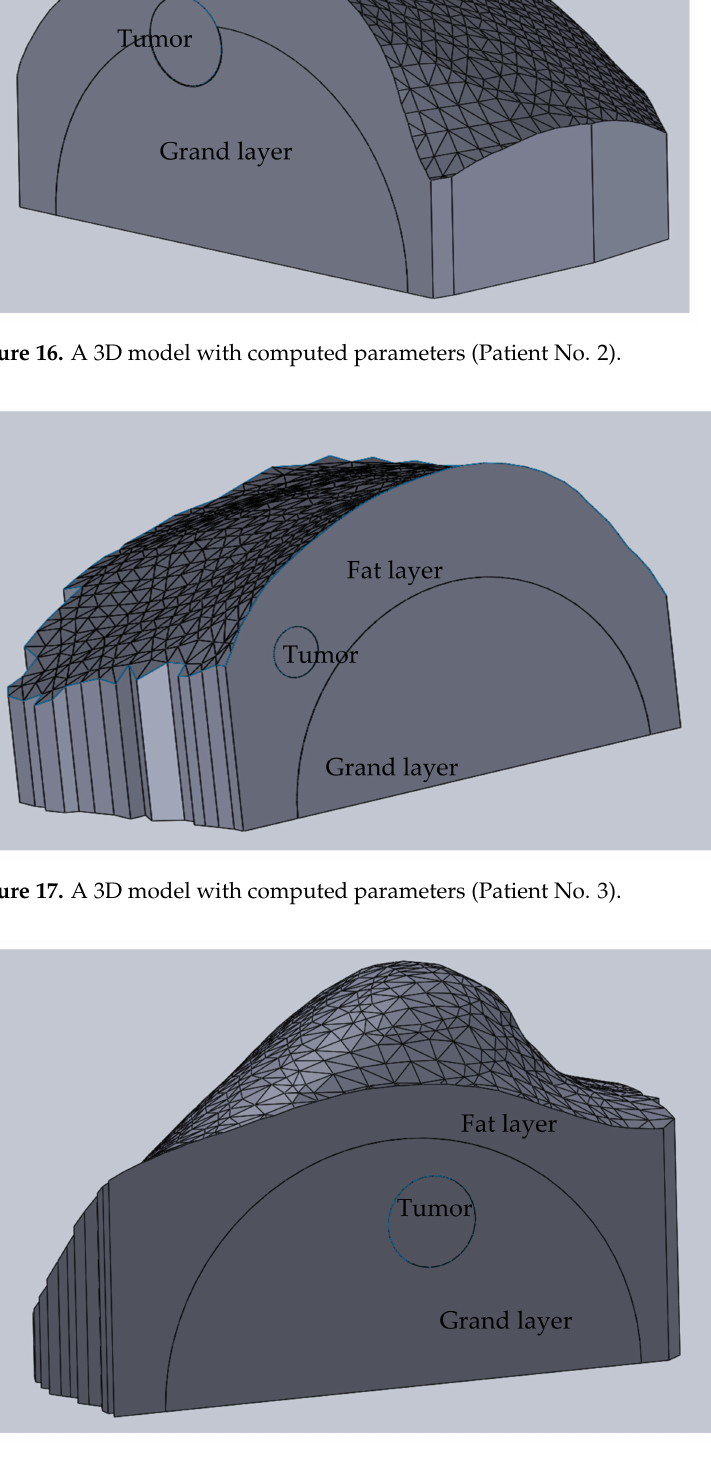
Figure 18. A 3D model with computed parameters (Patient No.